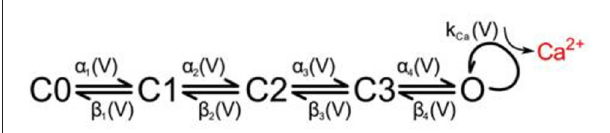
FIGURE 2 | State diagram for voltage-dependent calcium channels and resulting calcium influx in the presynaptic membrane. Reproduced with permission from Bartol et al. (2015).